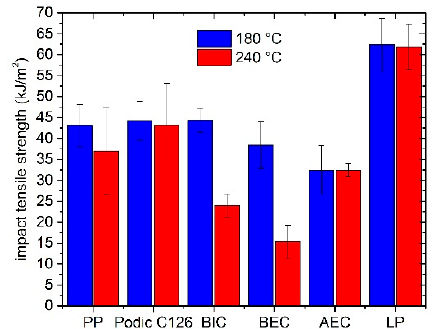
Figure 13. Results of the impact tensile test of the different model mixtures prepared at 180 °C and 240 °C.